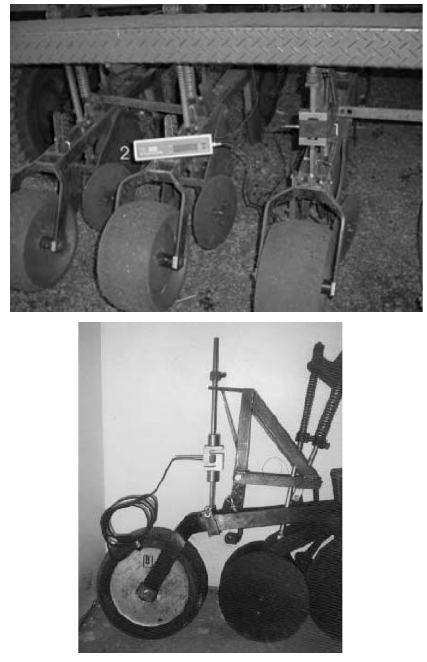
Figura 1. Vista geral dos equipamentos utilizados na determinação das cargas aplicadas no solo pela roda compactadora: (1) célula de carga, (2) visor.